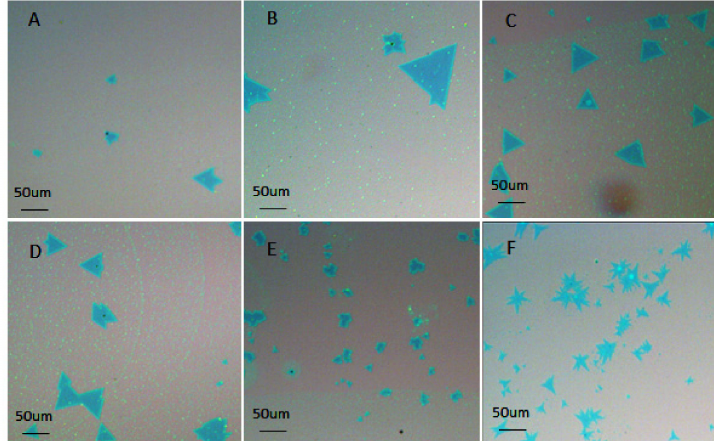
Figure 2. The optical images of the MoS 2 flakes grown on SiO 2 /Si substrate with different temperatures: